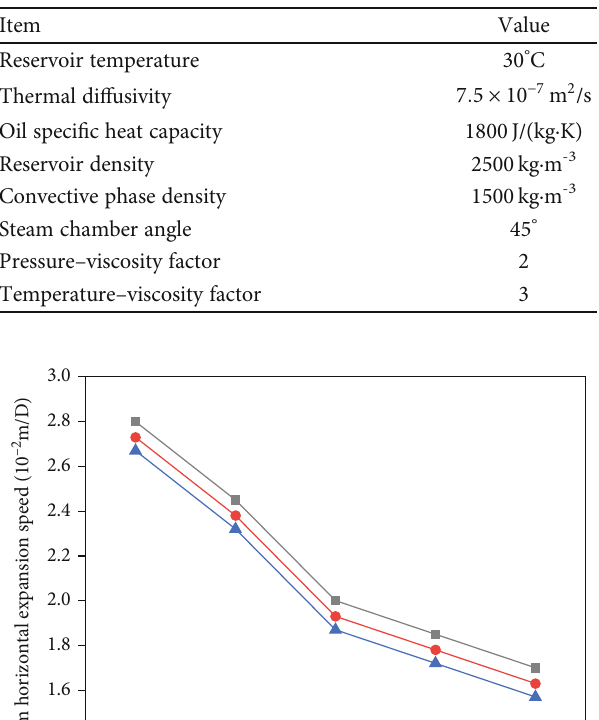
Table 2: Sensitivity analysis parameter table.